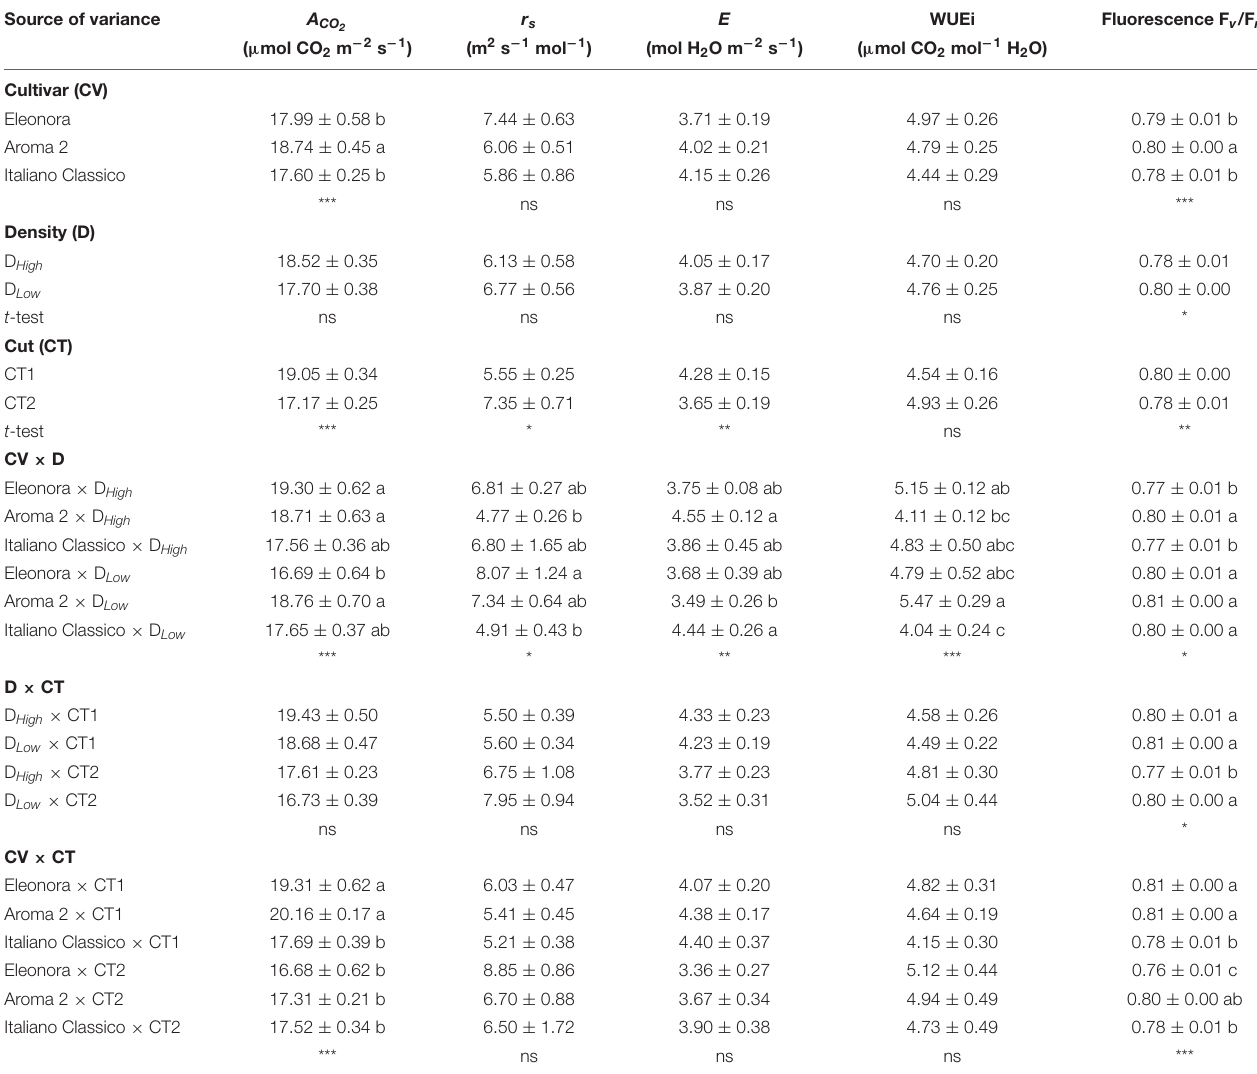
), stomatal resistance ( r s ), transpiration ( E ), instantaneous water use efficiency (WUEi), and chlorophyll fluorescence of Genovese TABLE 3 | Net photosynthesis ( A CO 2 basil cultivars Eleonora, Aroma 2, and Italiano Classico in light of density and cut treatments. Source of